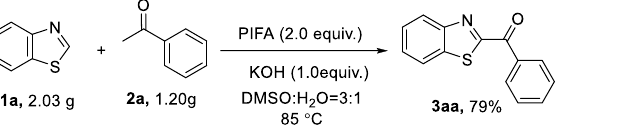
Figure 3. Gram-scale synthesis.